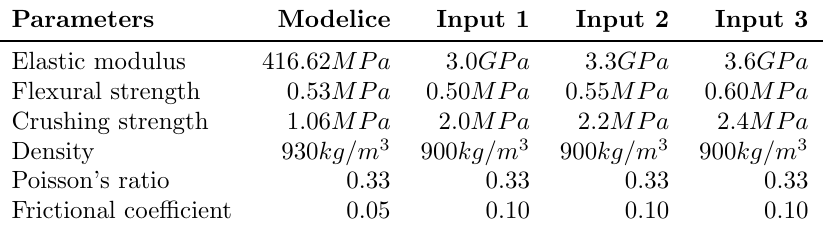
Table 4: Modified ice properties for the evaluation of sea ice